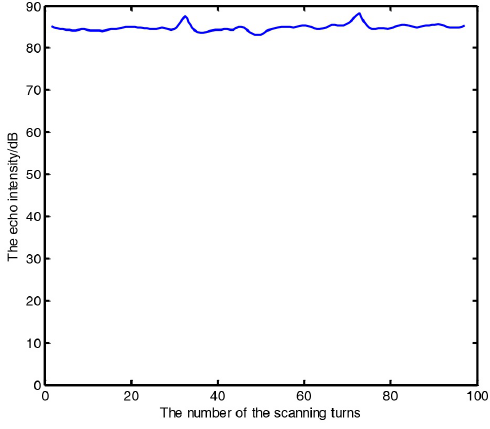
Fig. 6 The echo intensity of the big Luneburg lens reflector.